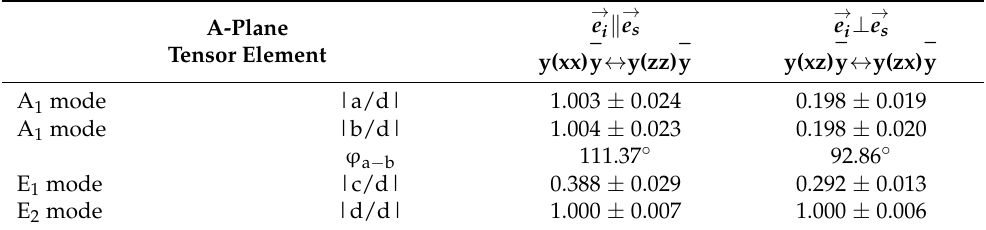
Table 1. The relative values of Raman tensor elements for A 1 , E 1, and E 2 modes of wurtzite 4H-SiC crystal, which are theoretical fitting results for the incident laser ( e i ) and scattered light ( e s ) under parallel and perpendicular polarization cases,